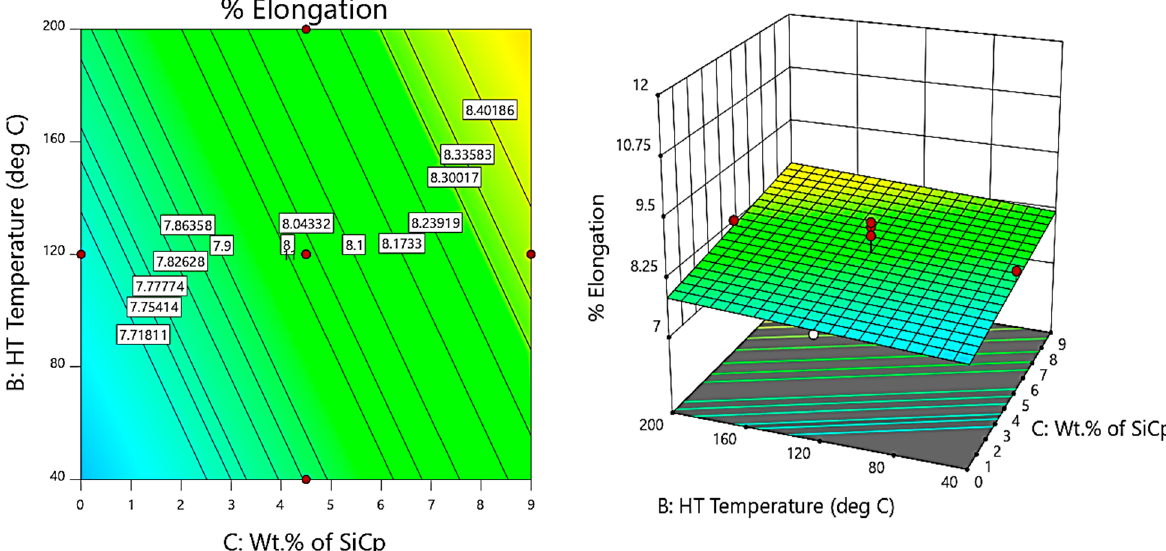
Figure 19. Contour plot for variation of % elongation with varying wt.% of SiC and HT temperature.